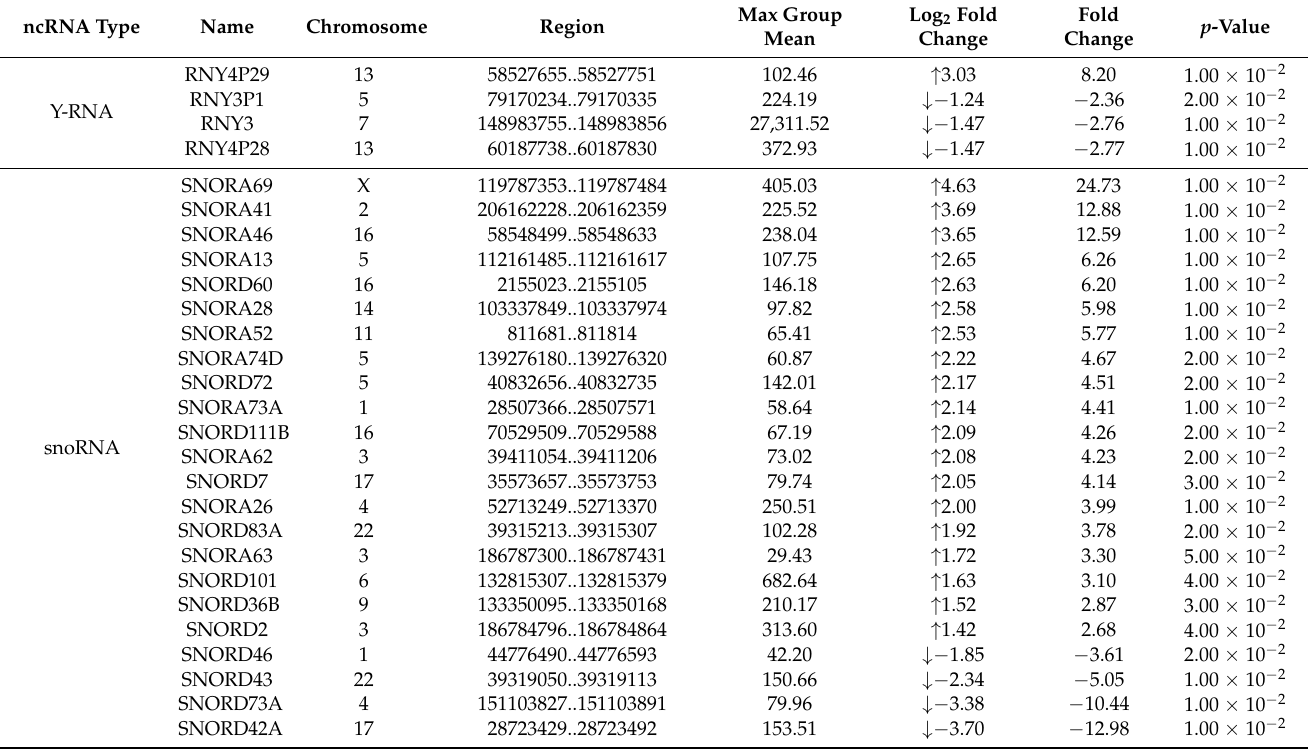
Table 9. Differentially expressed Y-RNAs (N = 4) and snoRNAs (N = 23) between individuals with more symptoms (severe) vs. less symptoms (mild) (Absolute fold change > 2; p <